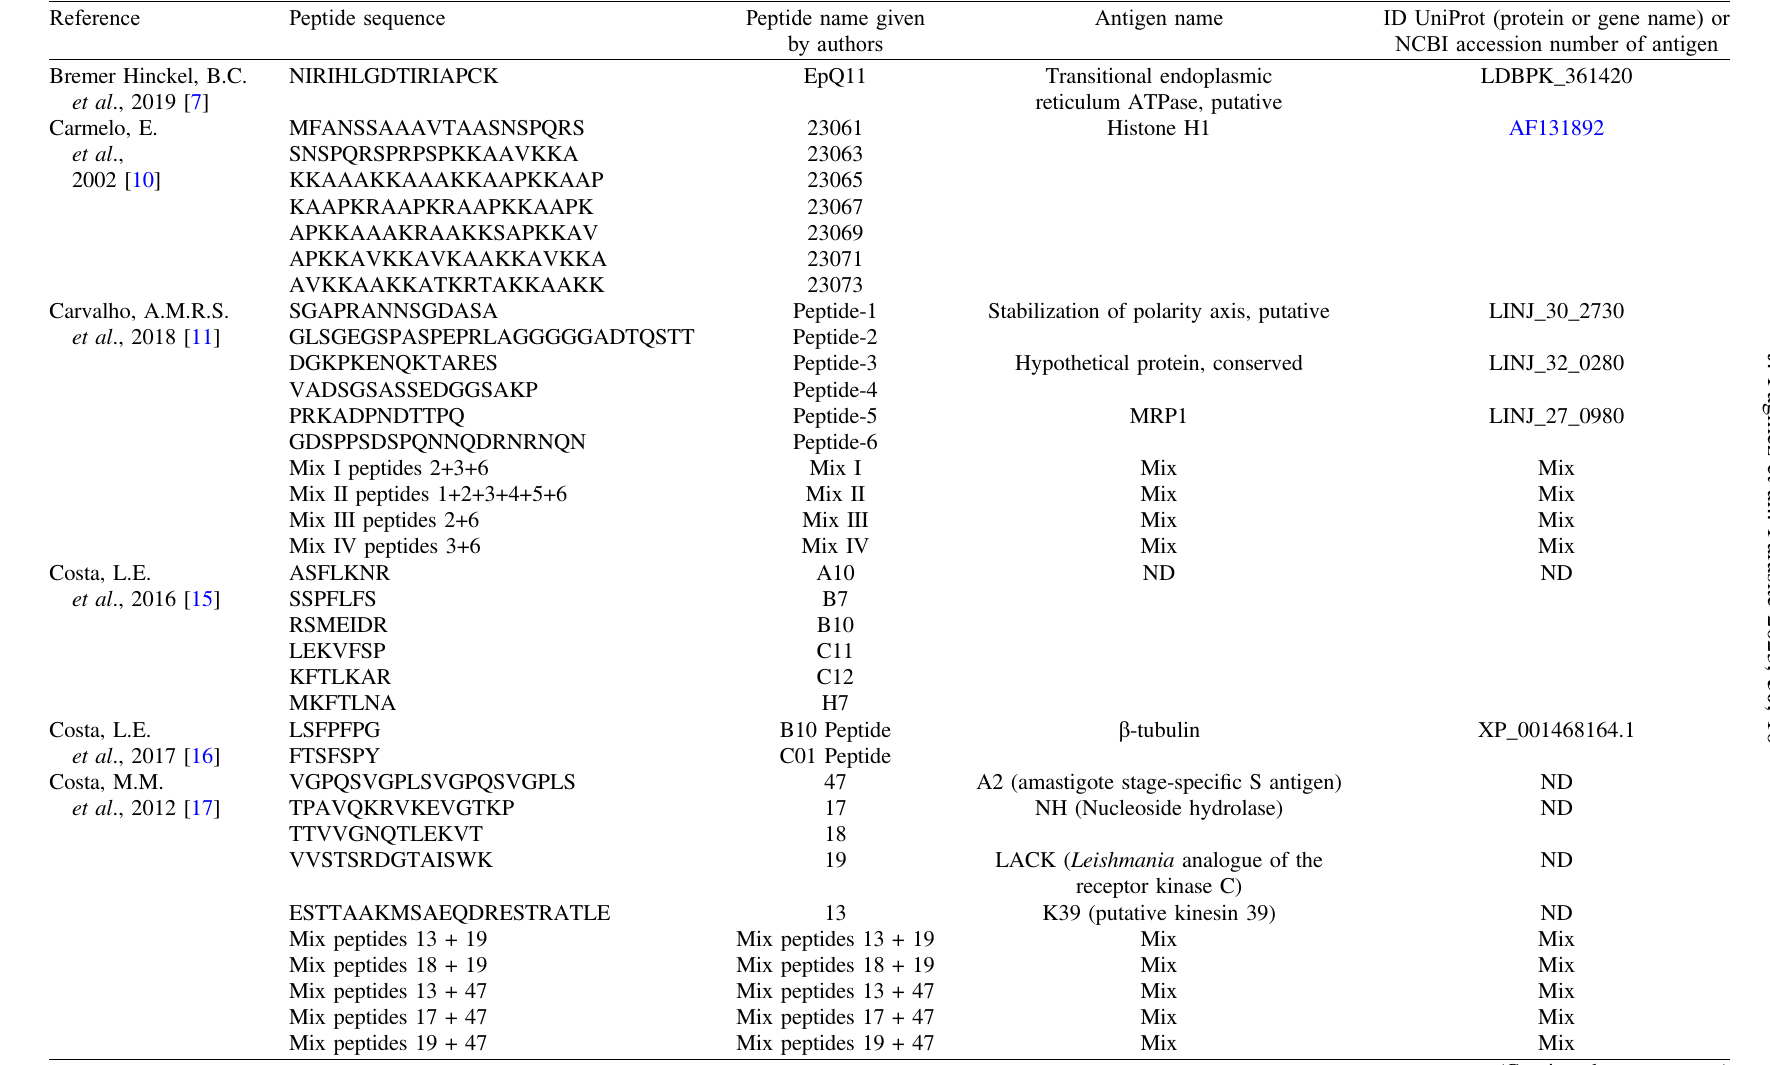
Table 2. List of peptides described in included